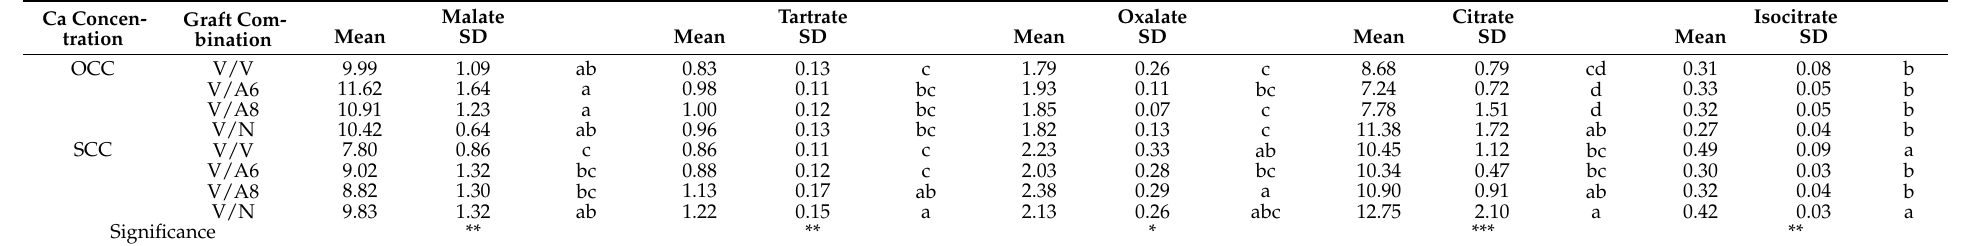
Table 4. Effects of calcium concentration and plant combinations on organic acid compositions (malate, tartrate, oxalate, citrate and isocitrate—g/kg DW) of pepper fruits at the end of the experiment (98